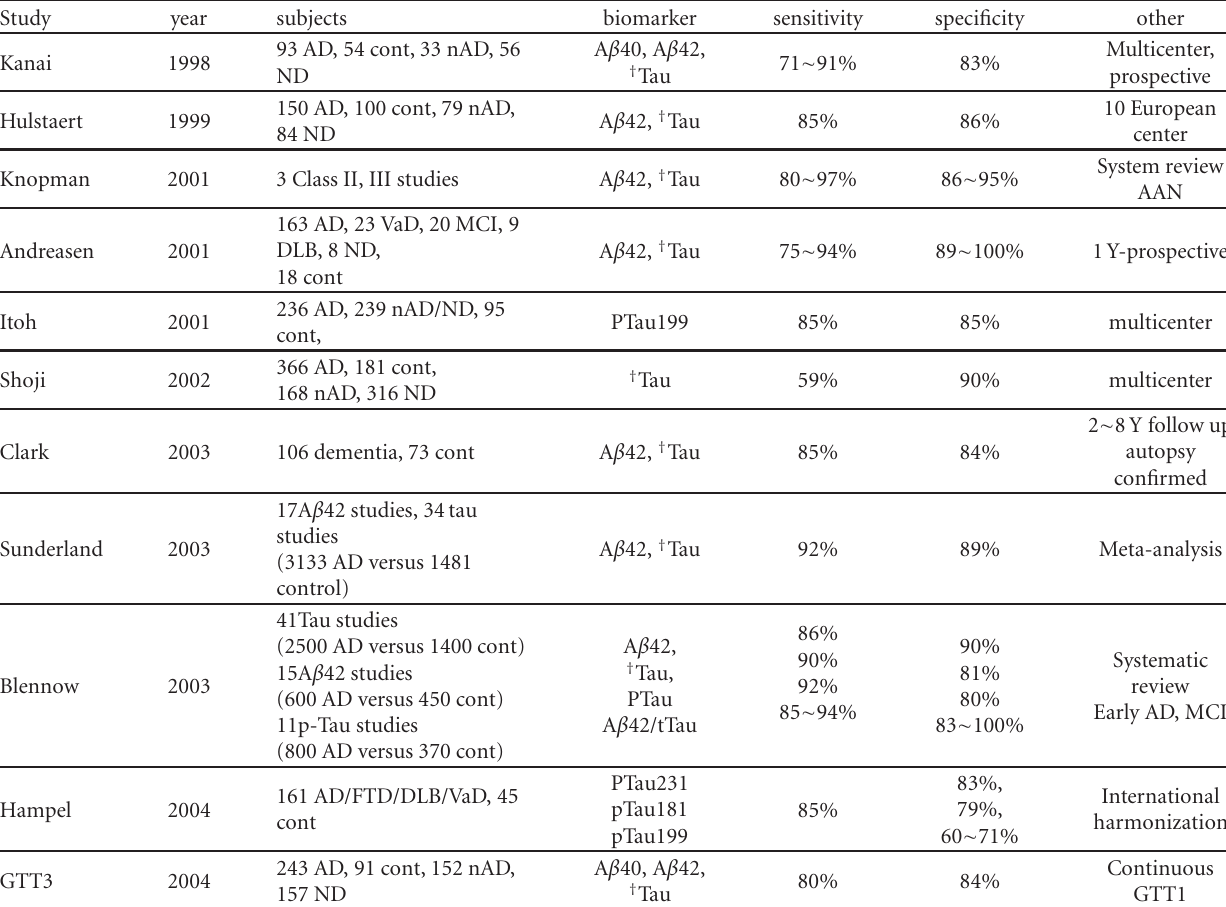
Table 1: Eleven major studies of CSF biomarkers for AD published between 1998 and